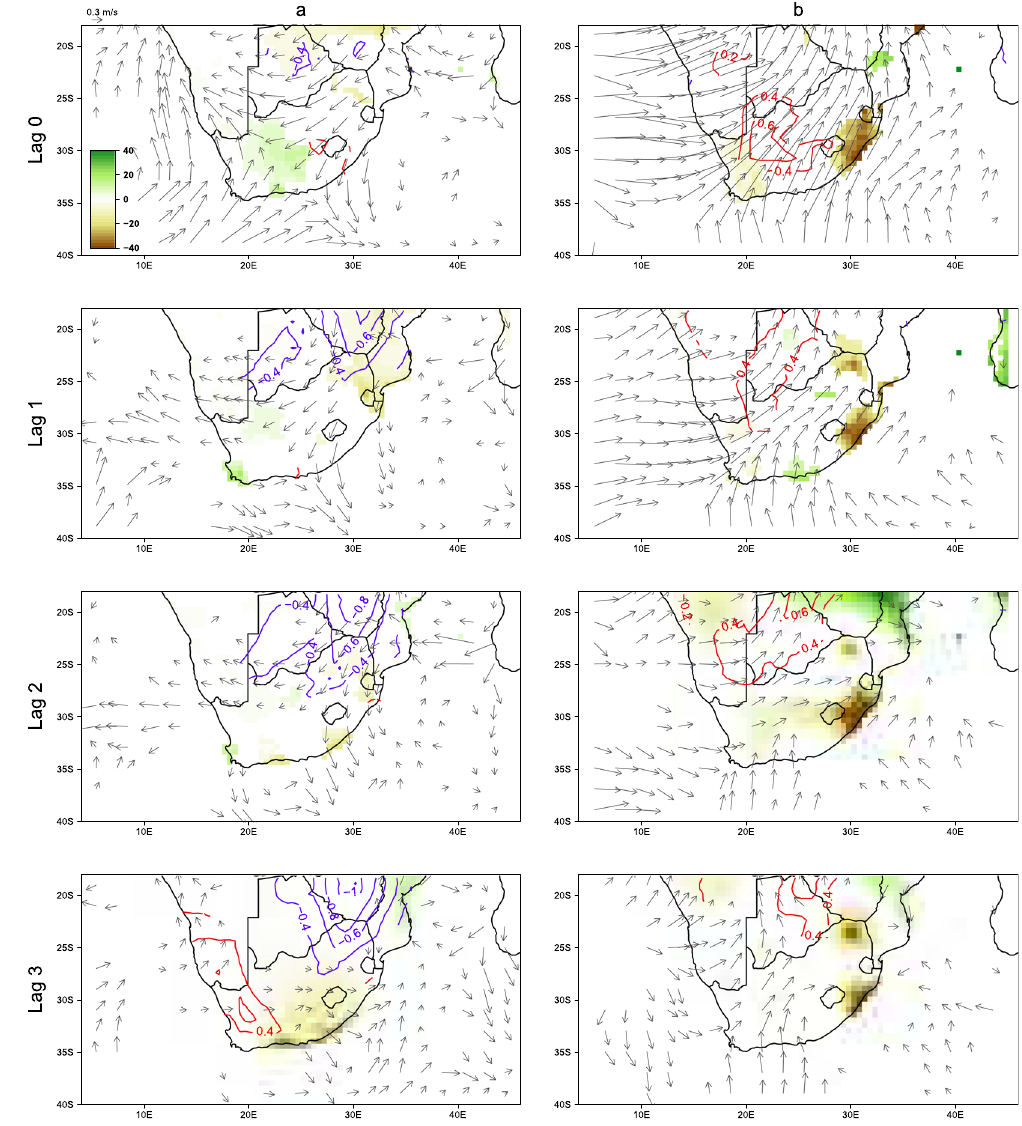
Figure 5. Composites of precipitation (shade, mm month − 1 ), mean temperature (contour, °C), and wind (vector, m s − 1 ) in southern Africa for ( a ) SON and ( b ) DJF. Differences in composite anomalies between